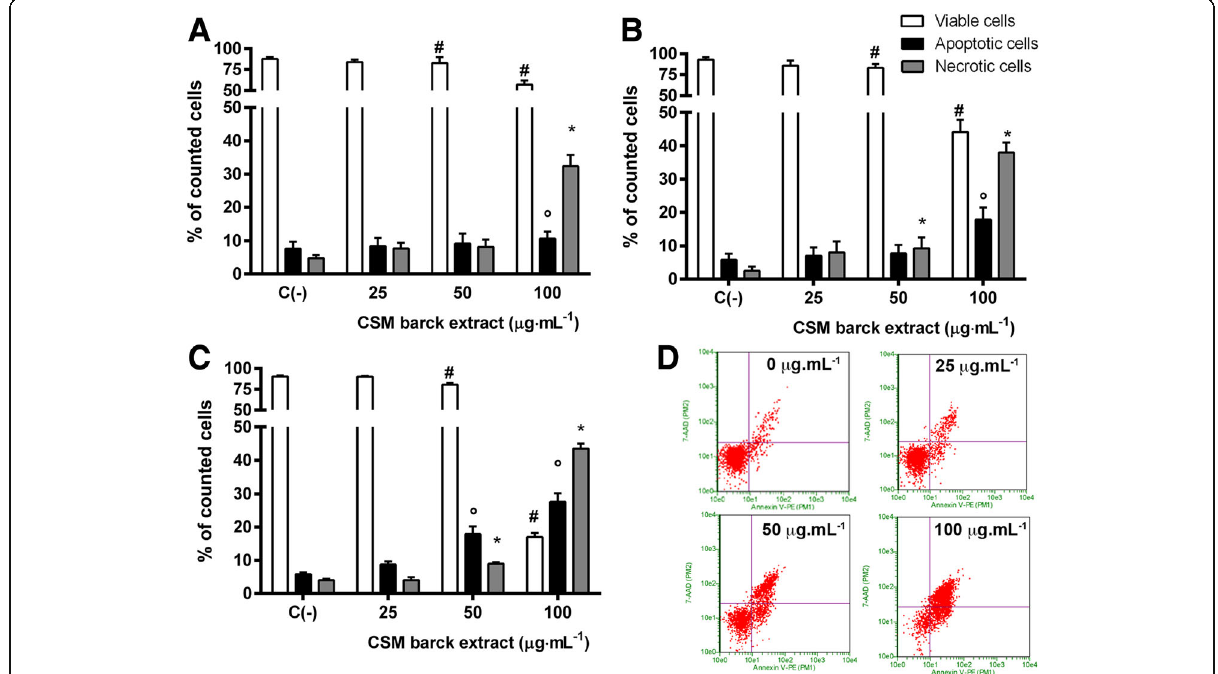
Fig. 2 Fraction of viable, apoptotic and necrotic Jurkat cells treated with CSM bark extract for 24 h ( a ), 48 h ( b ), 72 h ( c ) and representative dot plot of apoptosis analysis at 72 h treatment ( d ). Apoptosis was evaluated by FCM as described in Methods. Each bar represents the mean ± SEM of five independent experiments. Data were analyzed by repeated ANOVA followed by Bonferroni post-test. # p < 0.05 vs control viable cells, ° p < 0.05 vs control apoptotic cells, * p < 0.05 vs control necrotic